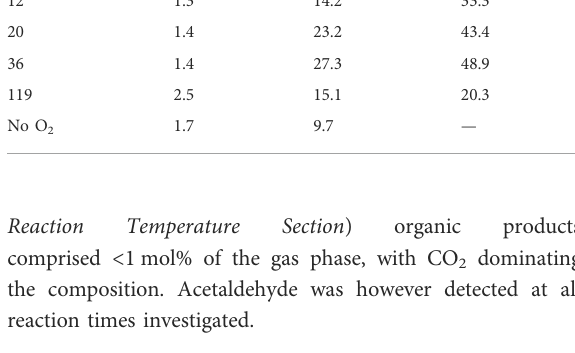
FIGURE 4 Distributionofliquid-phase ≤ C 3 productsatdifferentCO 2 :O 2 mole ratios. Reaction conditions: T = 300 ° C; V H2O = 7 ml; P CO2+air = 25 barg; reaction time = 4 h; 0.56 g Fe.